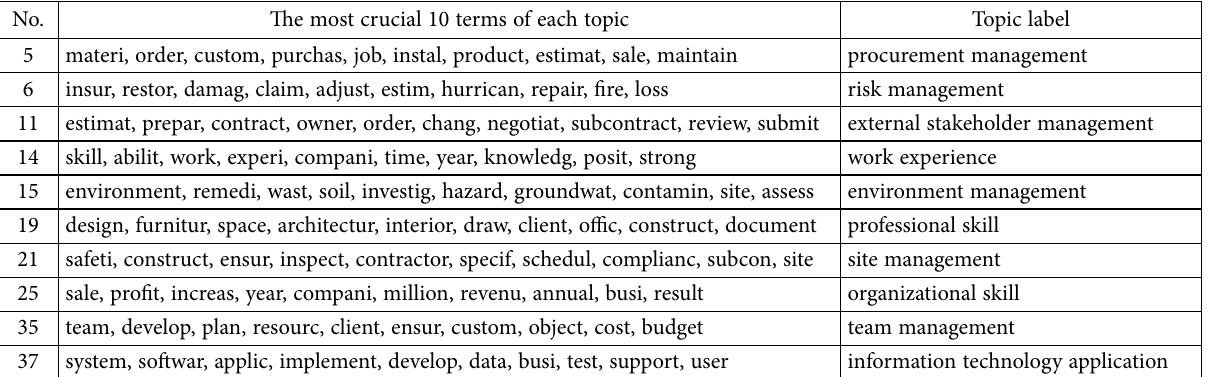
Table 2. The most crucial 10 terms of each topic (CPMs’ competence